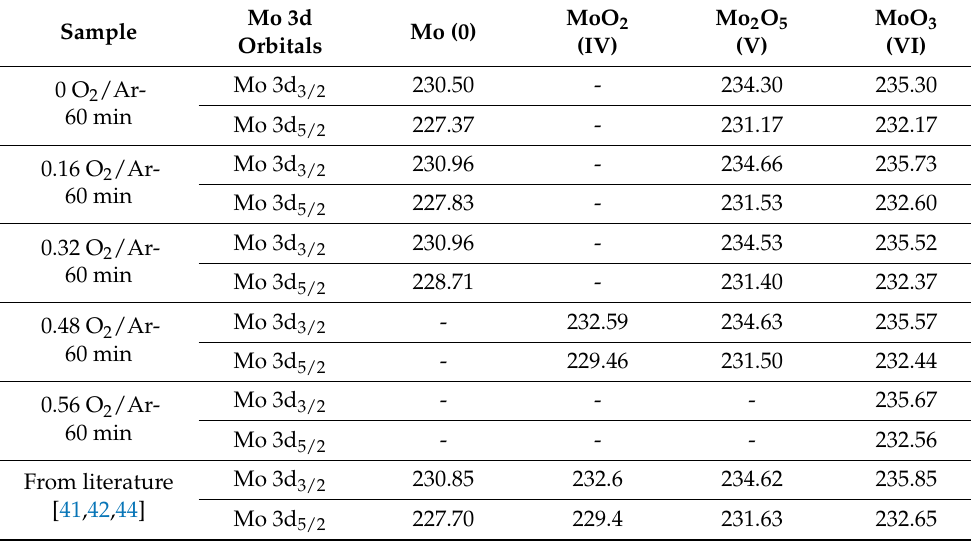
Table 2. Binding energies (eV) of the Mo 3d orbitals obtained by XPS and from literature.